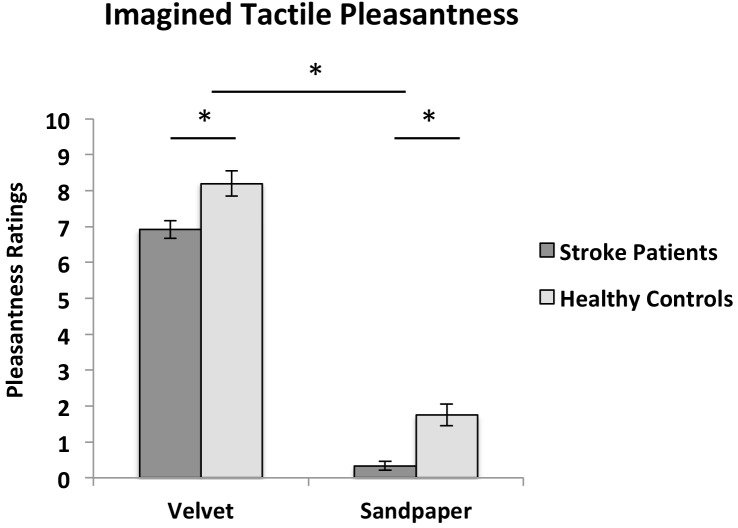
Average pleasantness ratings for imaginary touch.Patients rated how pleasant it would be to be touched by a typically pleasant material (i.e. velvet) and a typically unpleasant fabric (i.e. sandpaper). Error bars represent the standard error of the mean.